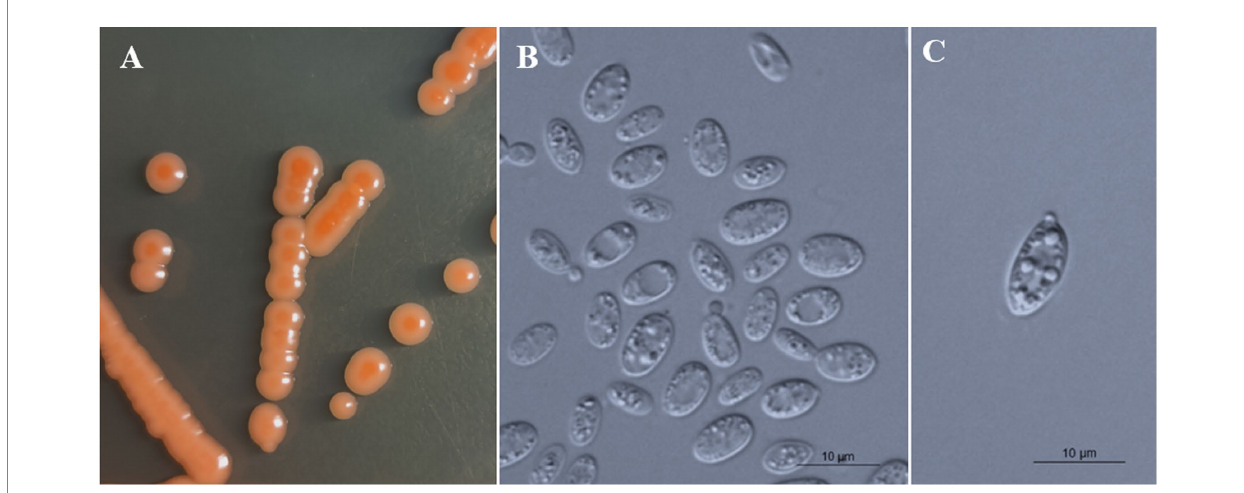
FIGURE 4 Morphological characteristics of Bannoa foliicola sp. nov. (CICC 33507, holotype). (A) Colony morphology on YM agar after growth for 7 d at 25 ° C. (B) Budding cells after growth for 7 d in YM broth at 25 ° C. (C) Ballistoconidia on CM agar after growth for 7 d at 25 ° C. Scale bars = 10 μ m.